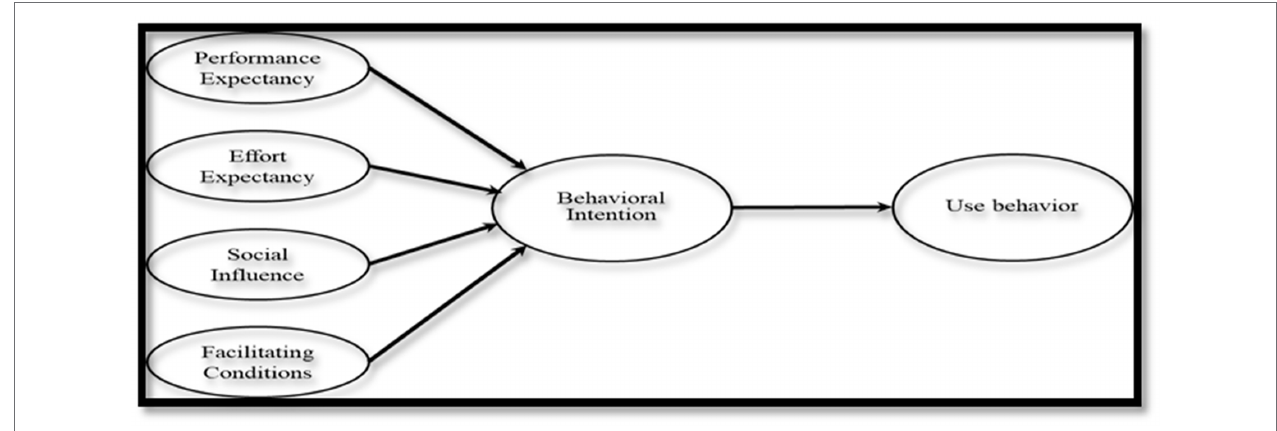
FIGURE 1 | The UTAUT model (Venkatesh et al.,